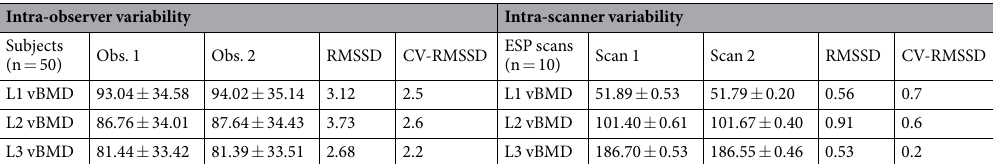
Table 4. Intra-observer and intra-scanner reproducibility of asynchronous quantitative computed tomography (QCT). CV, coefficient of variation; Obs., observation; RRMSD, root mean square of the standard deviation; vBMD, volumetric bone mineral density. Data represent the mean ± standard